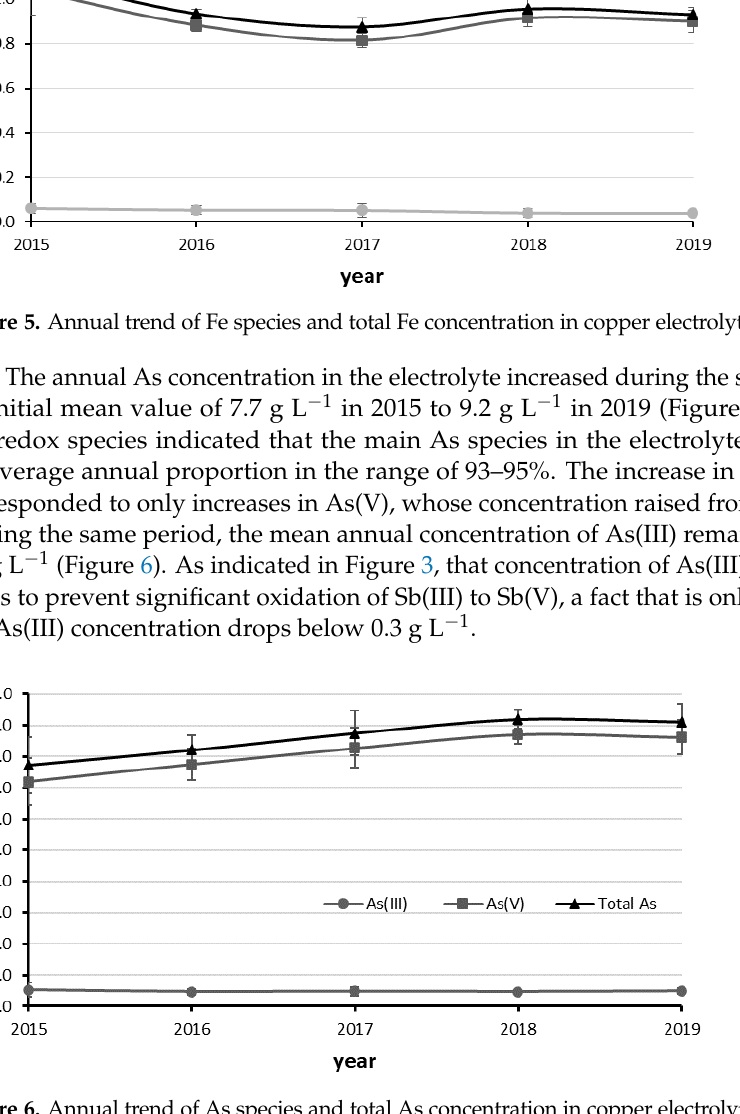
Figure 6. Annual trend of As species and total As concentration in copper electrolyte from 2015 to 2019.